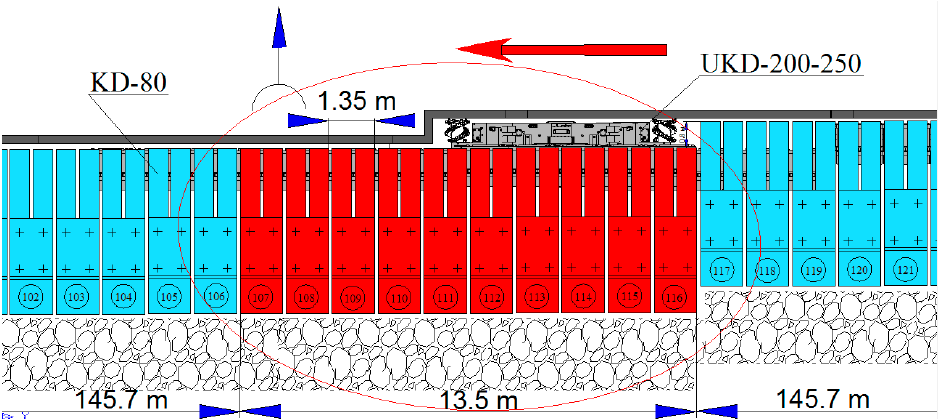
Figure 3. Zone of a convergence value that exceeds the maximum yield of hydraulic props for the conditions of a 450 m mining depth, 10 m distance from the displacement from an installation cham- ber, and 305 m of longwall length.